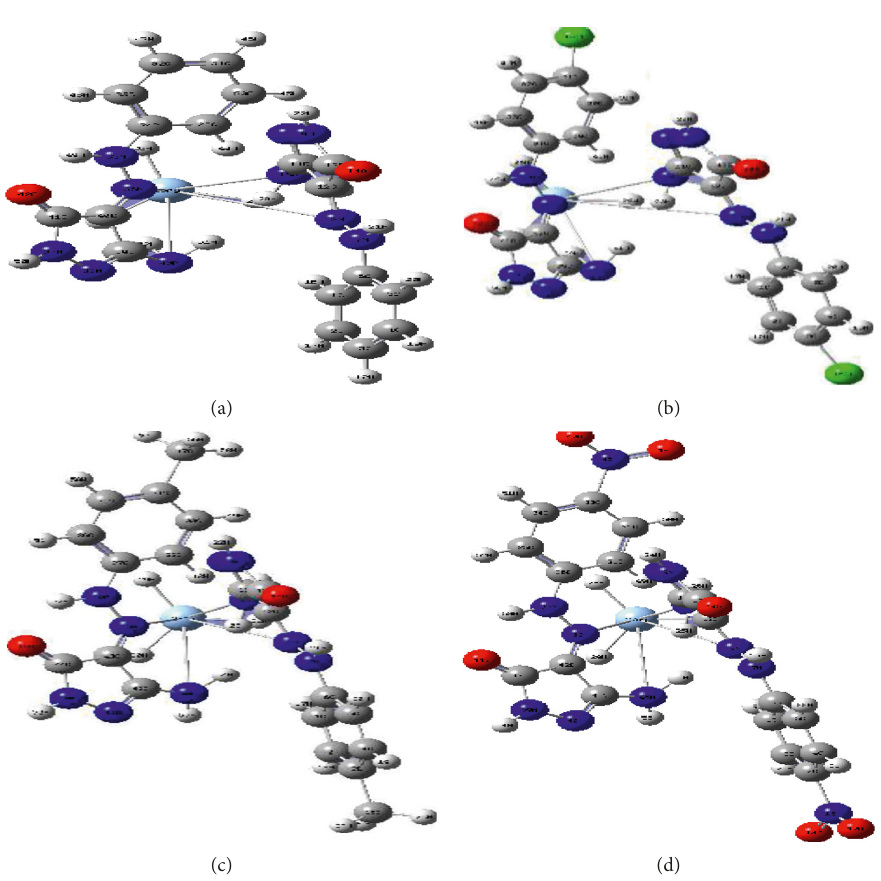
Figure 2: Optimized structures for Ag(I)-HL (1–4) complexes (a–d,